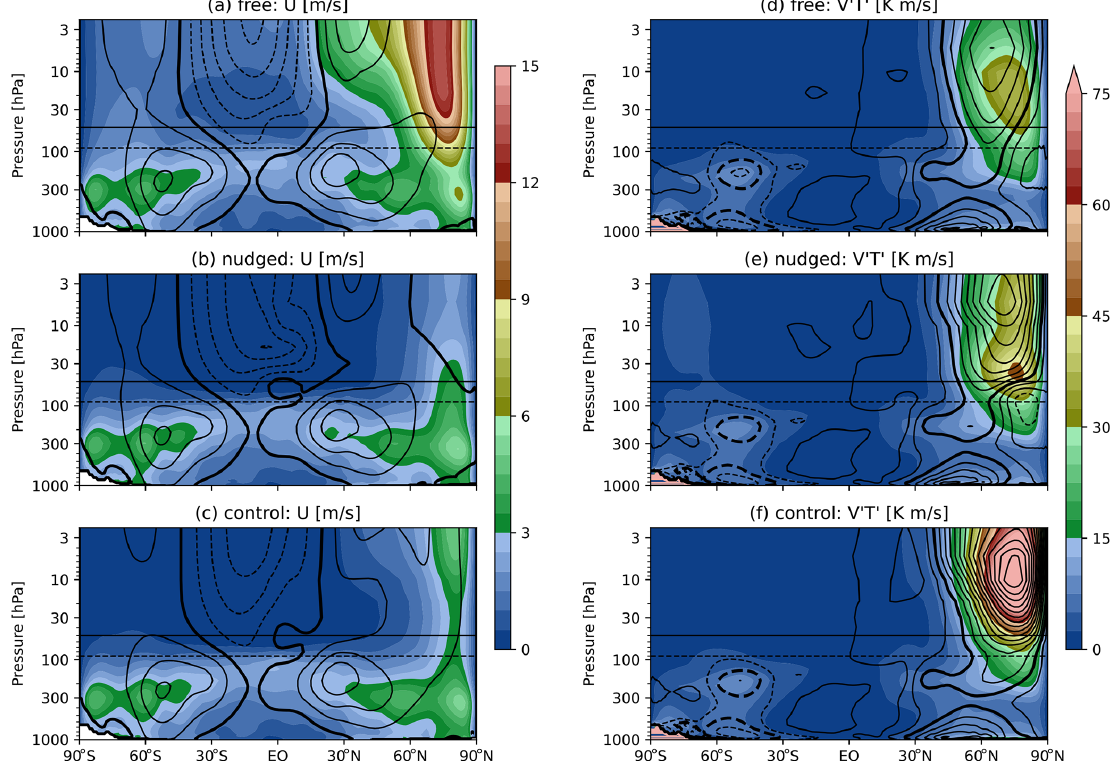
Figure 4. Ensemble mean (contour lines) and spread (shading) of (a–c) zonal-mean zonal wind and (d–f) meridional heat flux in CESM2 forecasts initialized at 12 February 2018, averaged over forecast days 10 to 40. The contour interval for the zonal wind is 10ms − 1 , and for the meridional heat flux it is 5Kms − 1 . The forecast ensemble in (a) and (d) is free running, while those in (b) and (e) and (c) and (f) correspond to the nudged and control integrations. The horizontal lines indicate the lower (dashed) and upper (solid) bounds of the nudging transition region; above the latter the nudging is imposed at full